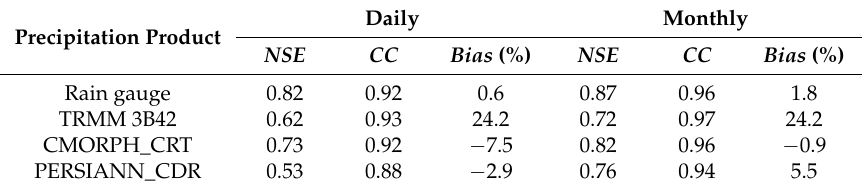
Table 5. Comparison of daily and monthly observed and simulated streamflow under Scenario I.